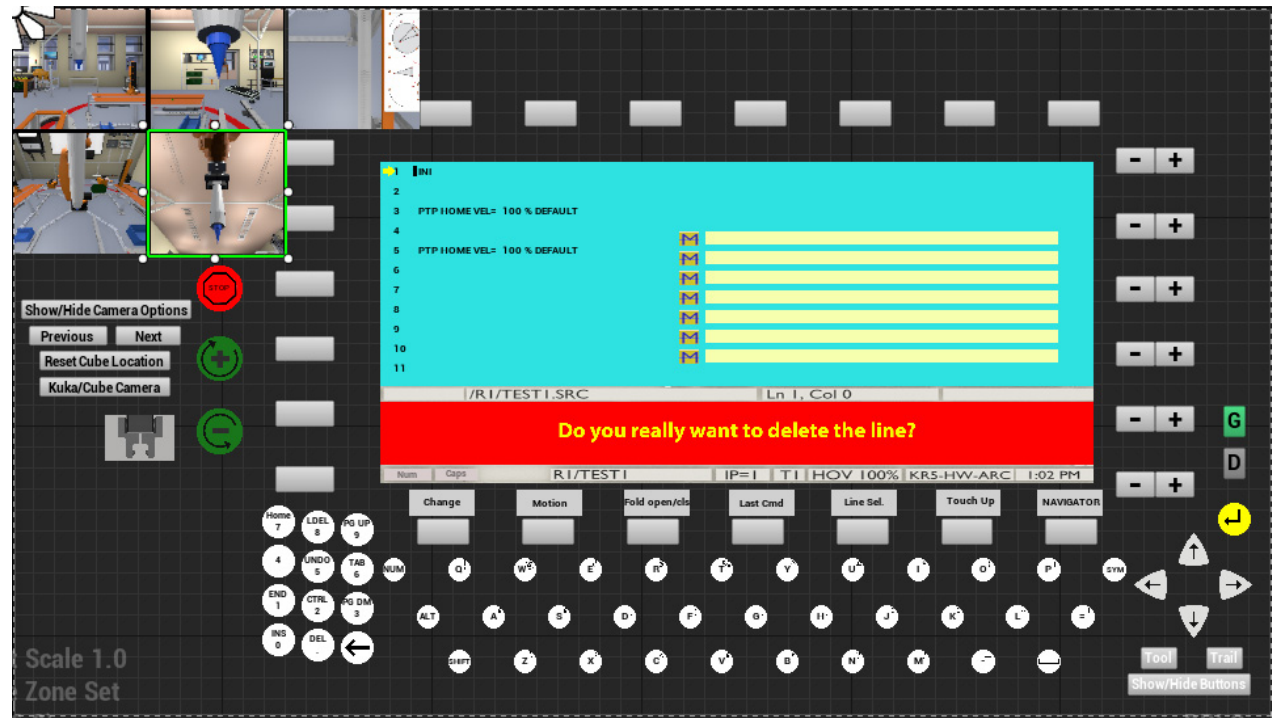
Figure 8. KUKA KR5 Virtual HMI – Widget Designer Tab.